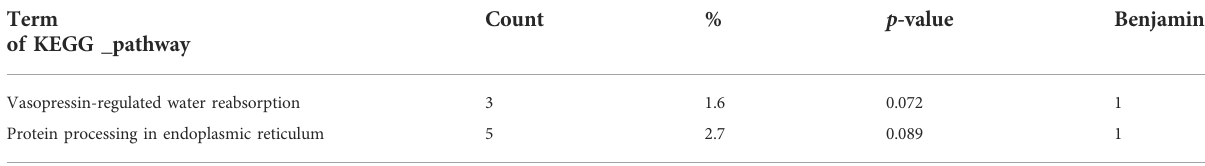
TABLE 1 KEGG pathway analysis results for genes with variable expression using next-generation sequencing. Term of KEGG _pathway